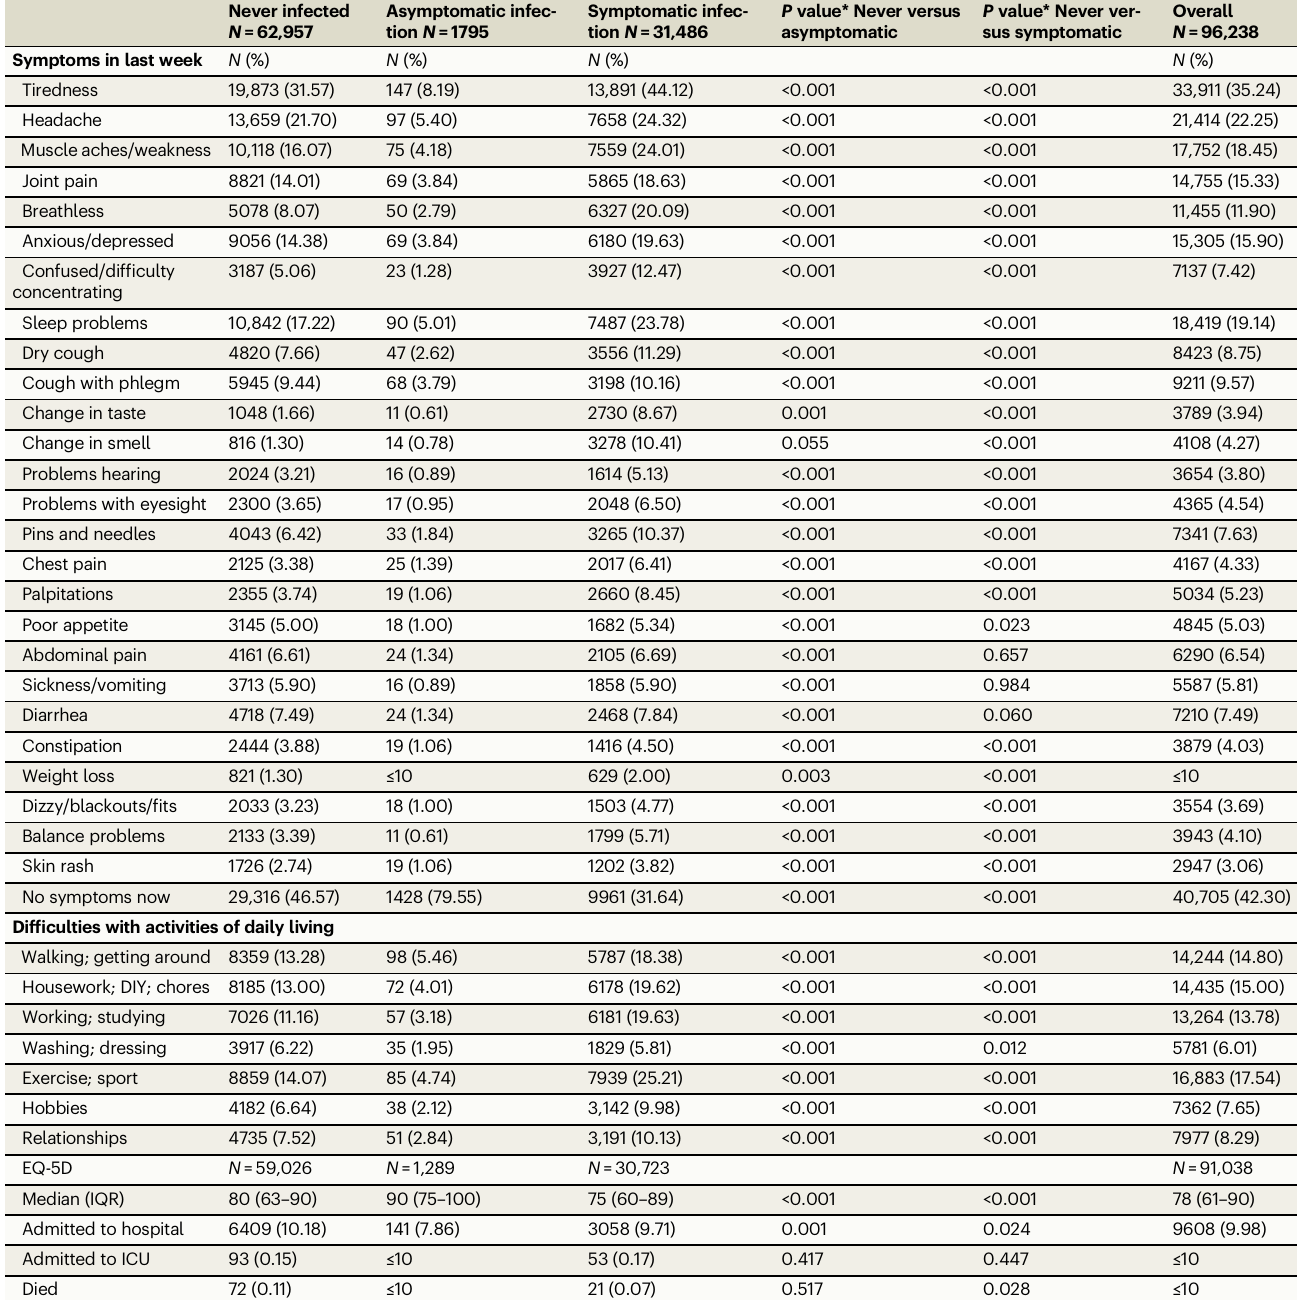
Table 2 | Crude outcomes of participants by infection status and symptomatology